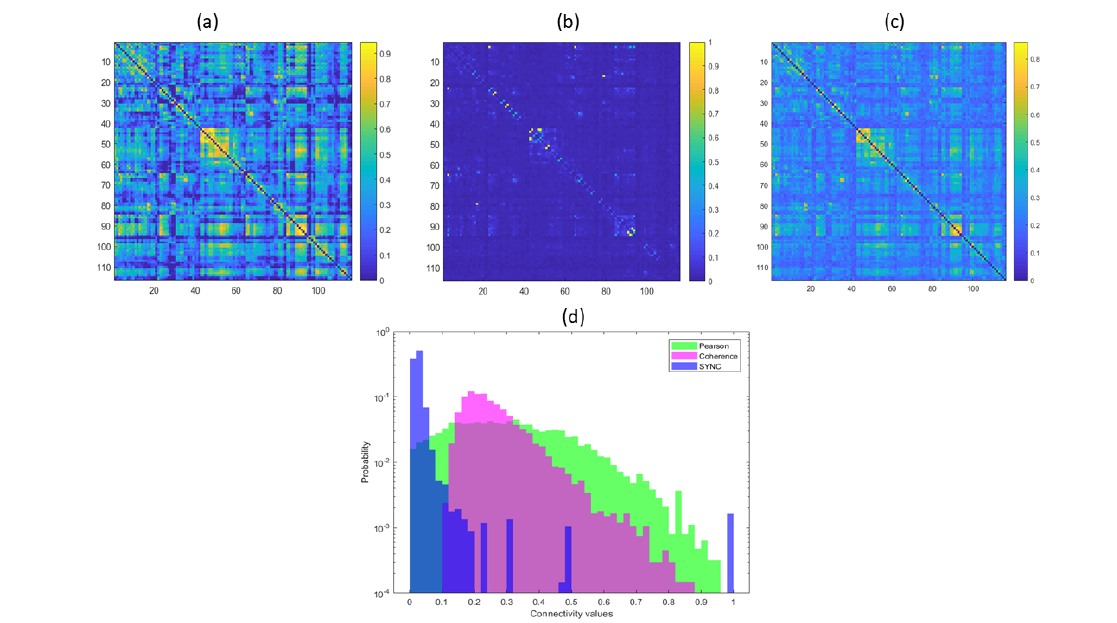
Figure 3. Pearson correlation matrix ( a ), SYNC matrix ( b ) and coherence matrix ( c ) with the empirical probability distributions of the links of the three matrices in semi-logarithmic scale ( d